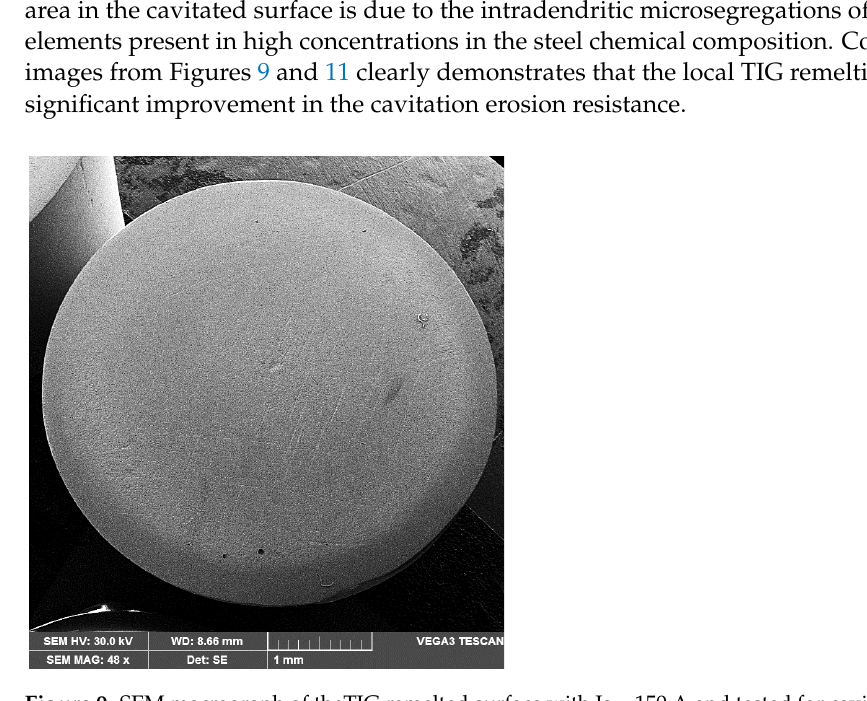
Figure 9. SEM macrograph of theTIG remelted surface with Is = 150 A and tested for cavitation 165 min.